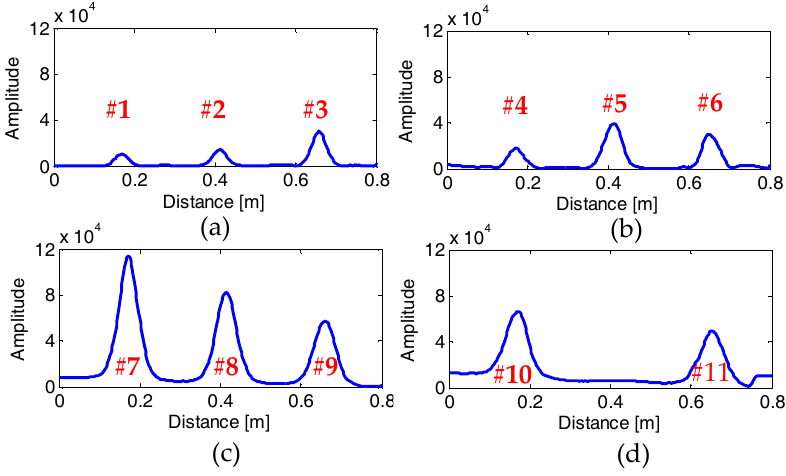
Figure 10. Recorded EMI curves on the four concrete specimens ( a – d ) after pre-processing. The serial numbers of the tested rebars are marked above or below the impulse EMI response of the eleven rebars.